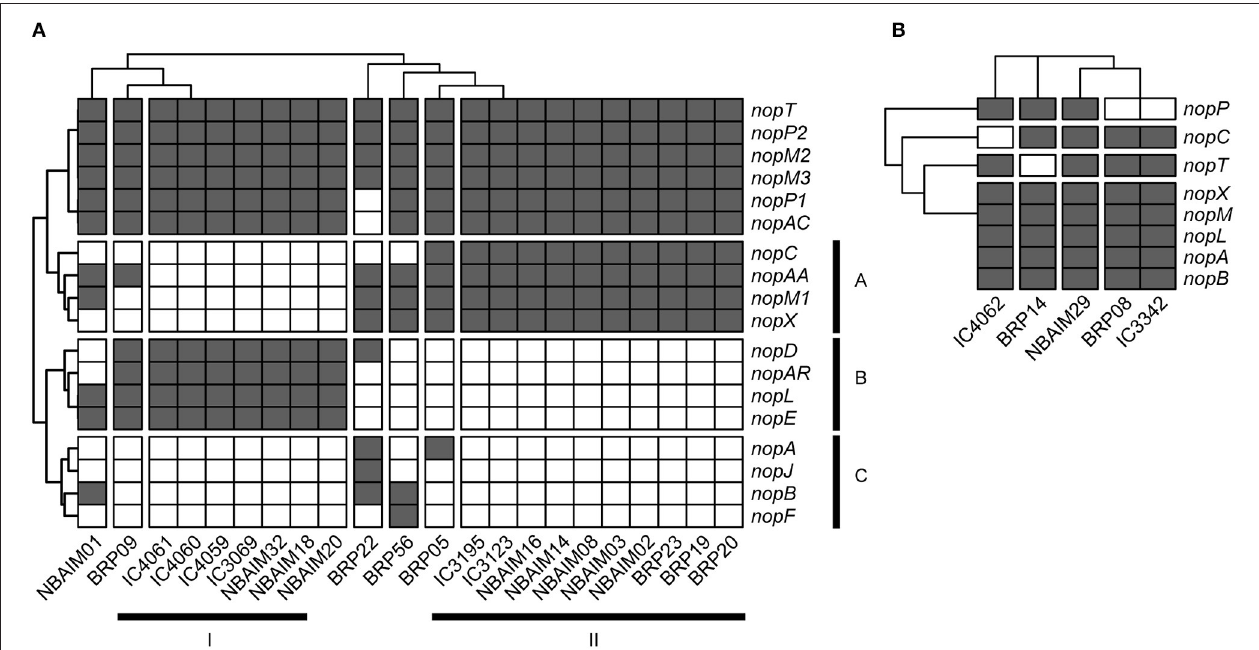
FIGURE 7 | The presence and absence of nop genes. (A) Bradyrhizobium IU and IC strains are shown as a heat map. (B) Ensifer IU and IC strains are shown as a heat map.